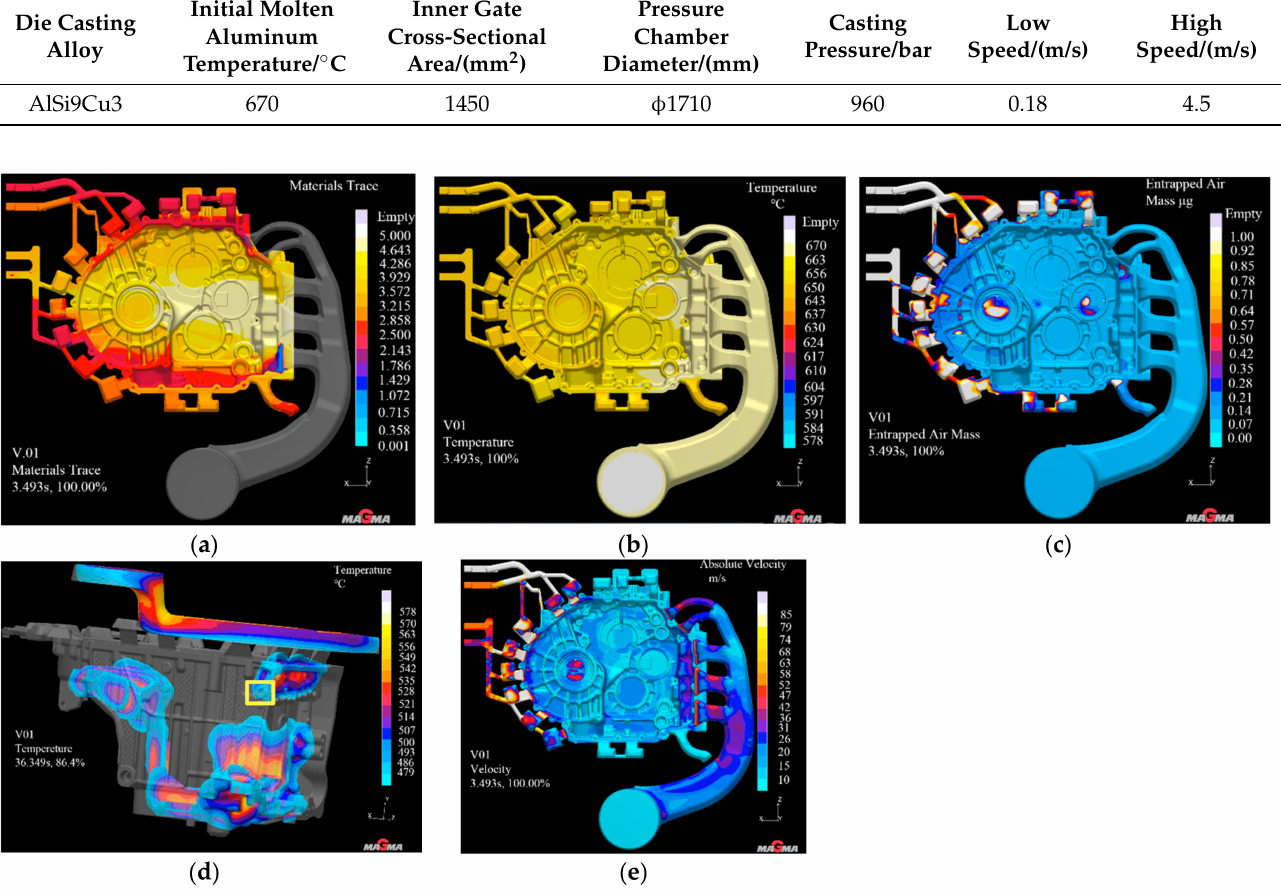
Figure 8. Simulation results of aluminum alloy gearbox housing. ( a ) Material tracking neogram; ( b ) filling temperature neogram; ( c ) entrainment quality neogram; ( d ) solidification neogram; ( e ) filling velocity